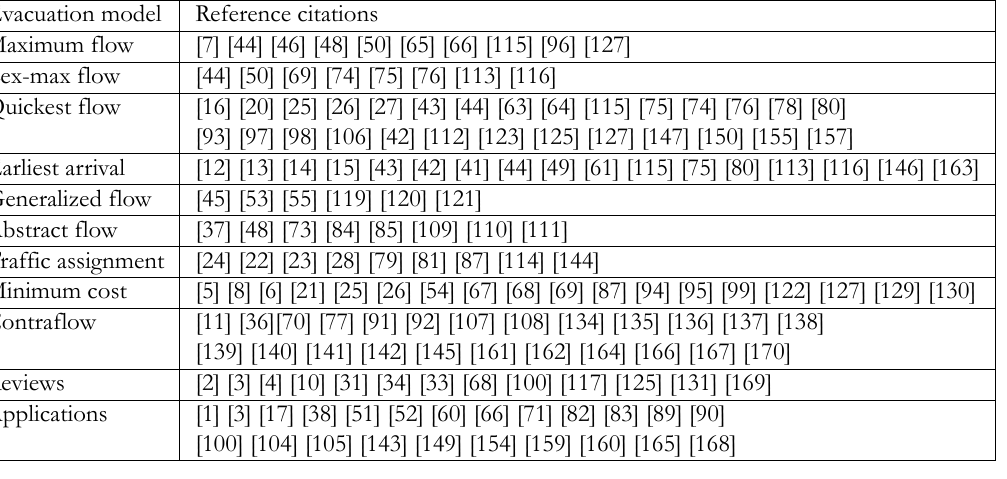
Table 1: A distribution of literature flow in different classes of evacuation planning problems. The numbers refer to the item in the list of